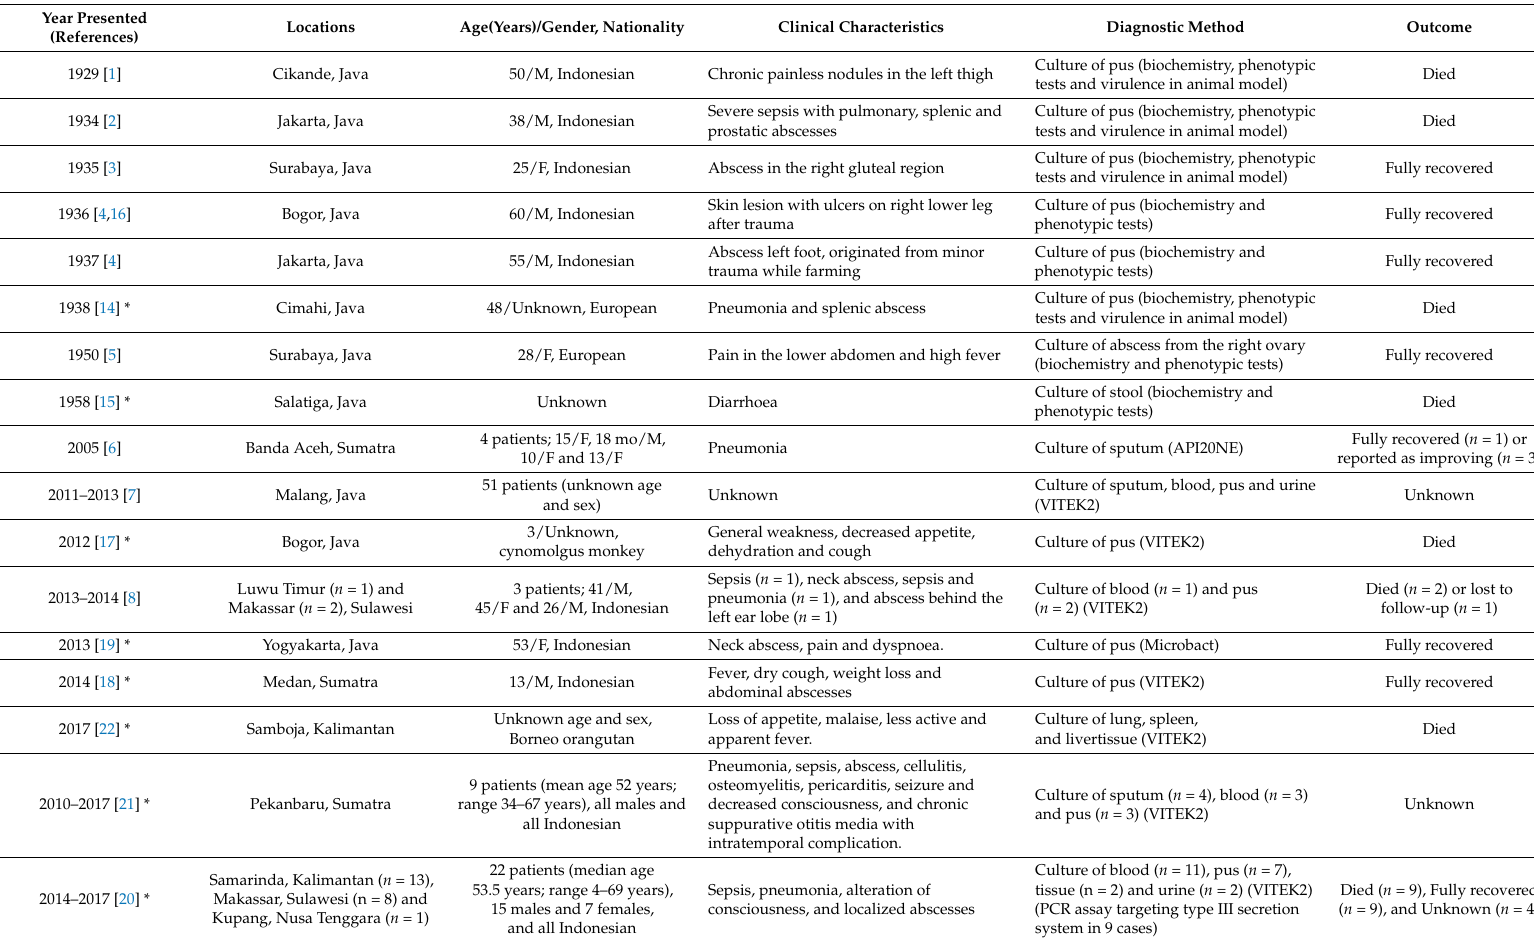
Table 1. Previously reported indigenous human and animal melioidosis cases in Indonesia ( n = 101